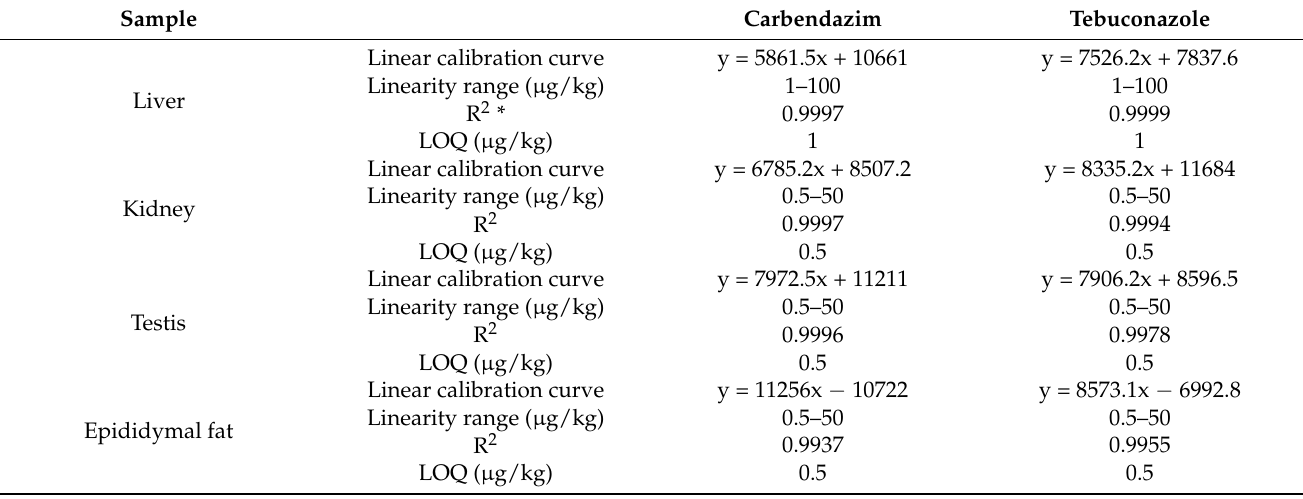
Table 3. Linear calibration curves, linearity ranges, and LOQs of carbendazim and tebuconazole in the samples.